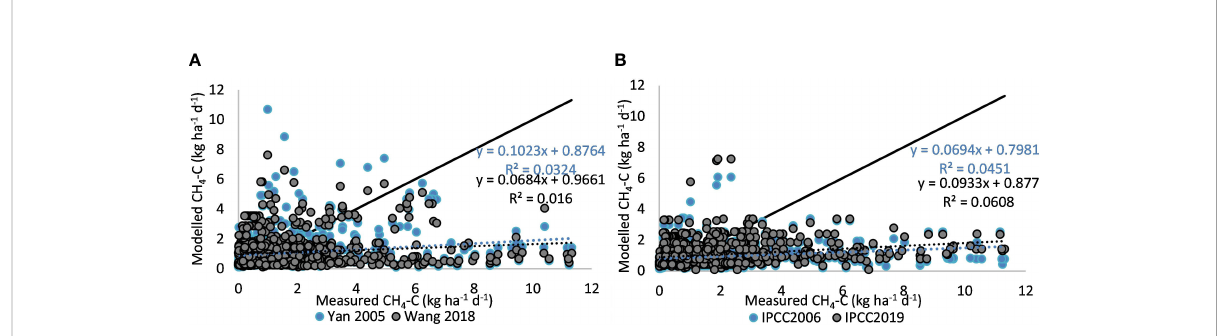
FIGURE 2 Comparison of modelled against observed emission for the four empirical models: (A) Tier 3 Yan and Wang models, (B) IPCC, 2006 and 2019 models (solid line indicates